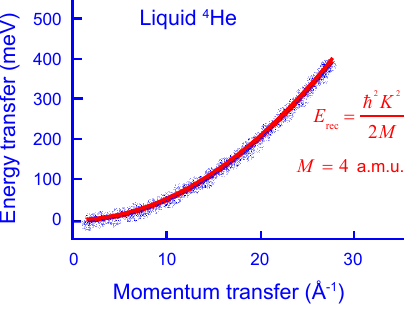
Figure 1. Schematic representation (blue points) of measured dynamic structure factor S ( K , E ) of liquid helium [25]. The red line is the calculated recoil parabola, for the mass of 4 He, shown as a guide to the eye. The white-blue ribbon around the recoil parabola represent data points measured with the time-of-flight spectrometer ARCS [15] (Figure taken from reference [26] with permission of